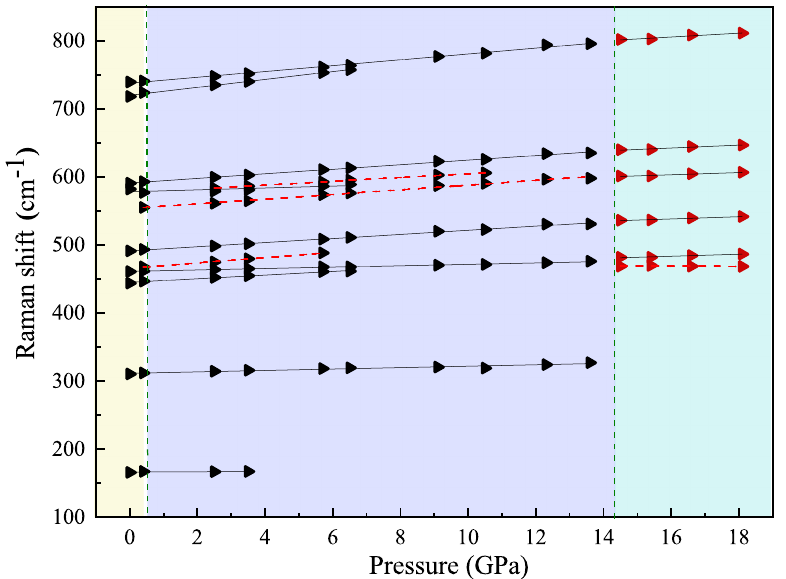
Figure 10. Frequency shift of Raman modes with increasing pressure. The black and red symbols represent the Raman modes of the ambient phase and those observed above 14 GPa, respectively. Different shadings illustrate the changes in the Raman spectrum. The red dashed lines highlight new modes emerging under